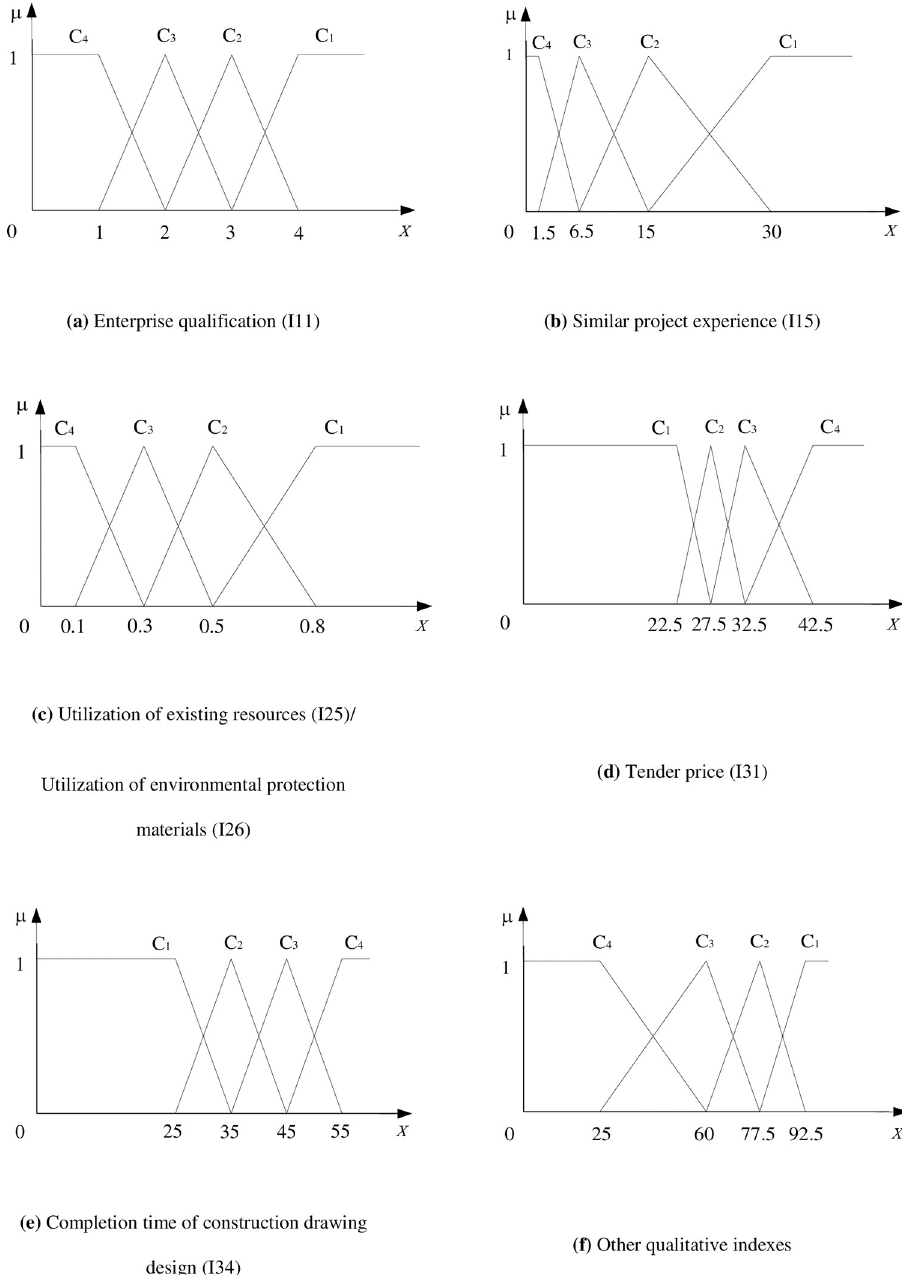
Fig 3. Single-index unascertained measure function.